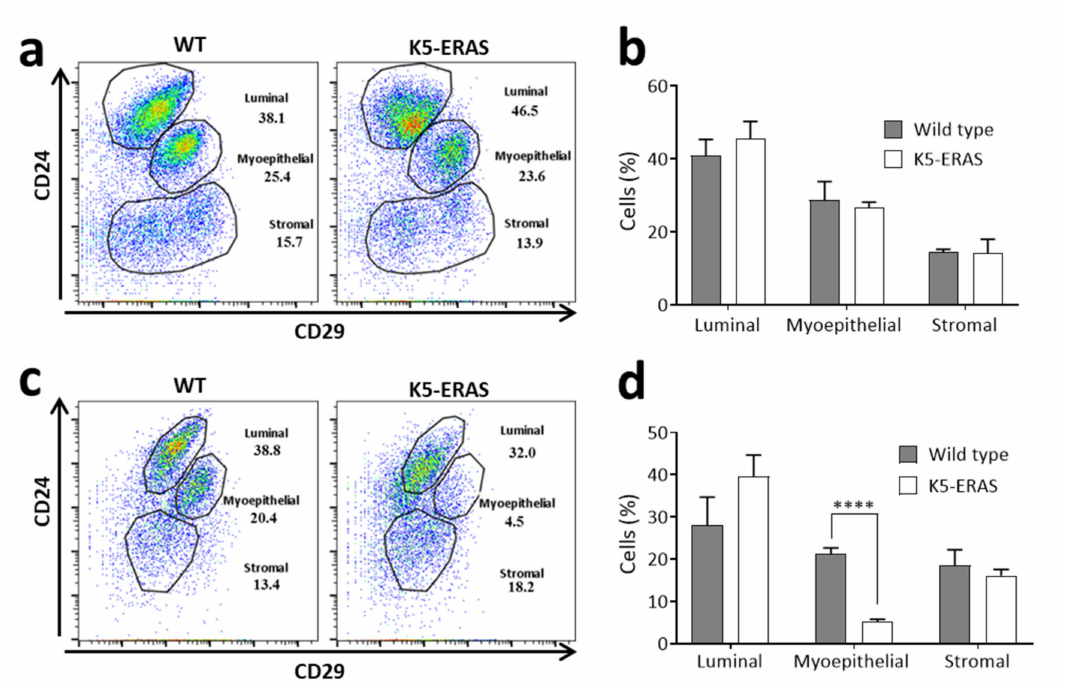
Figure 10. Flow cytometry study of cell-surface markers in K5-ERAS mammary cells. ( a , b ) Analysis of CD24 and CD29 expression in the mammary cell population negative for hematopoietic, erythroid and endothelial linage markers in 10-week-old virgin female mice. ( a ) Example of the population distribution in one WT and one K5-ERAS female mouse; ( b ) mean and standard deviation of the data obtained from four mice of each genotype. The differences observed are statistically non-significant. ( c , d ) The same analyses were performed in 7-month-old virgin female mice. ( c ) Representative plot of one WT and one K5-ERAS female mouse; ( d ) mean and SD of four different mice of each genotype. **** p <